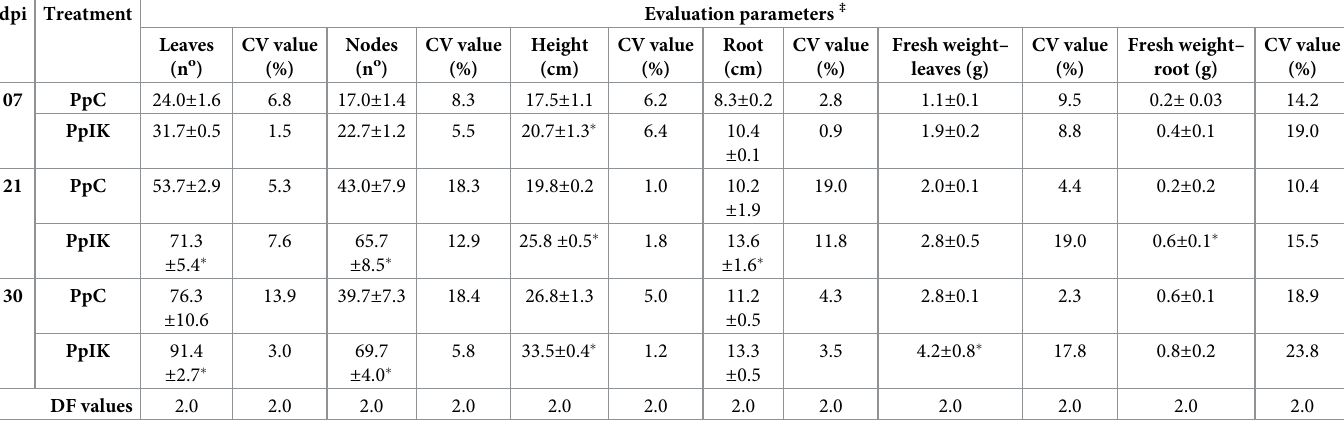
Table 2. Developmental parameters of Peperomia pellucida after inoculation with Klebsiella variicola . dpi Treatment Evaluation parameters ‡